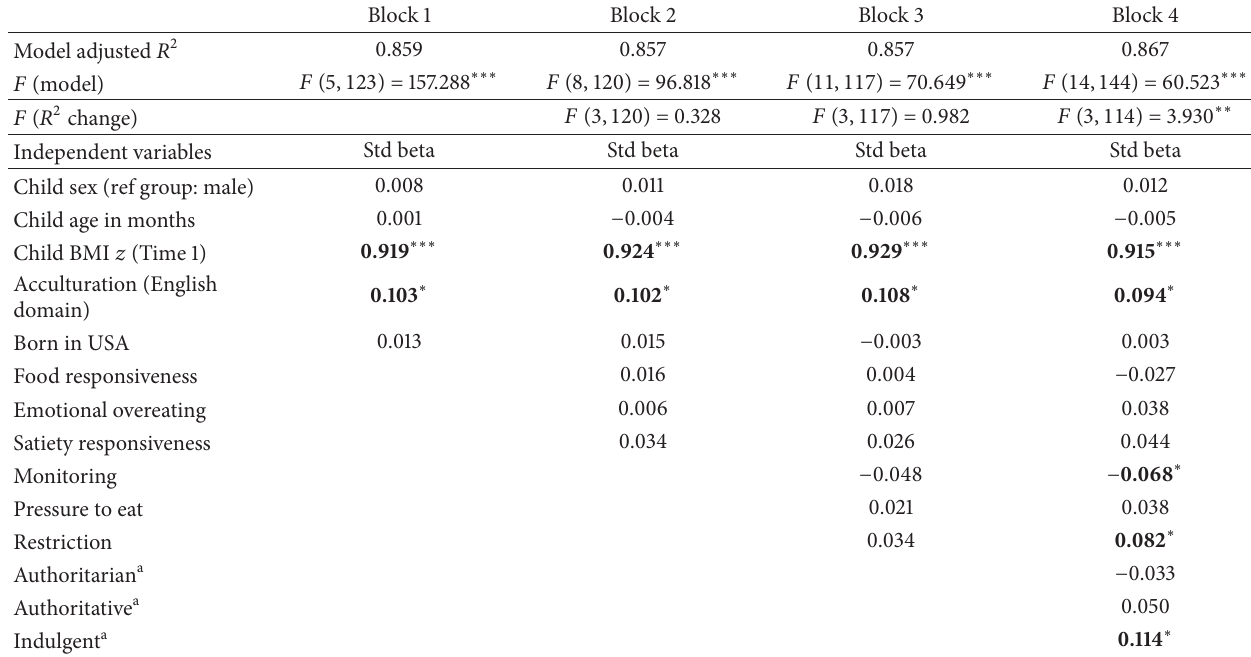
Table 3: Regression analysis predicting child BMI 𝑧 at Time 2 ( 𝑁 = 129